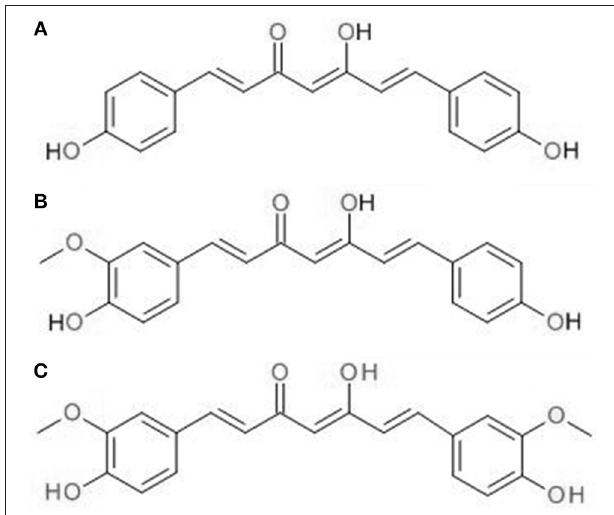
FIGURE 1 | Chemical structures of (A) CUR, (B) demethoxycurcumin, (C)